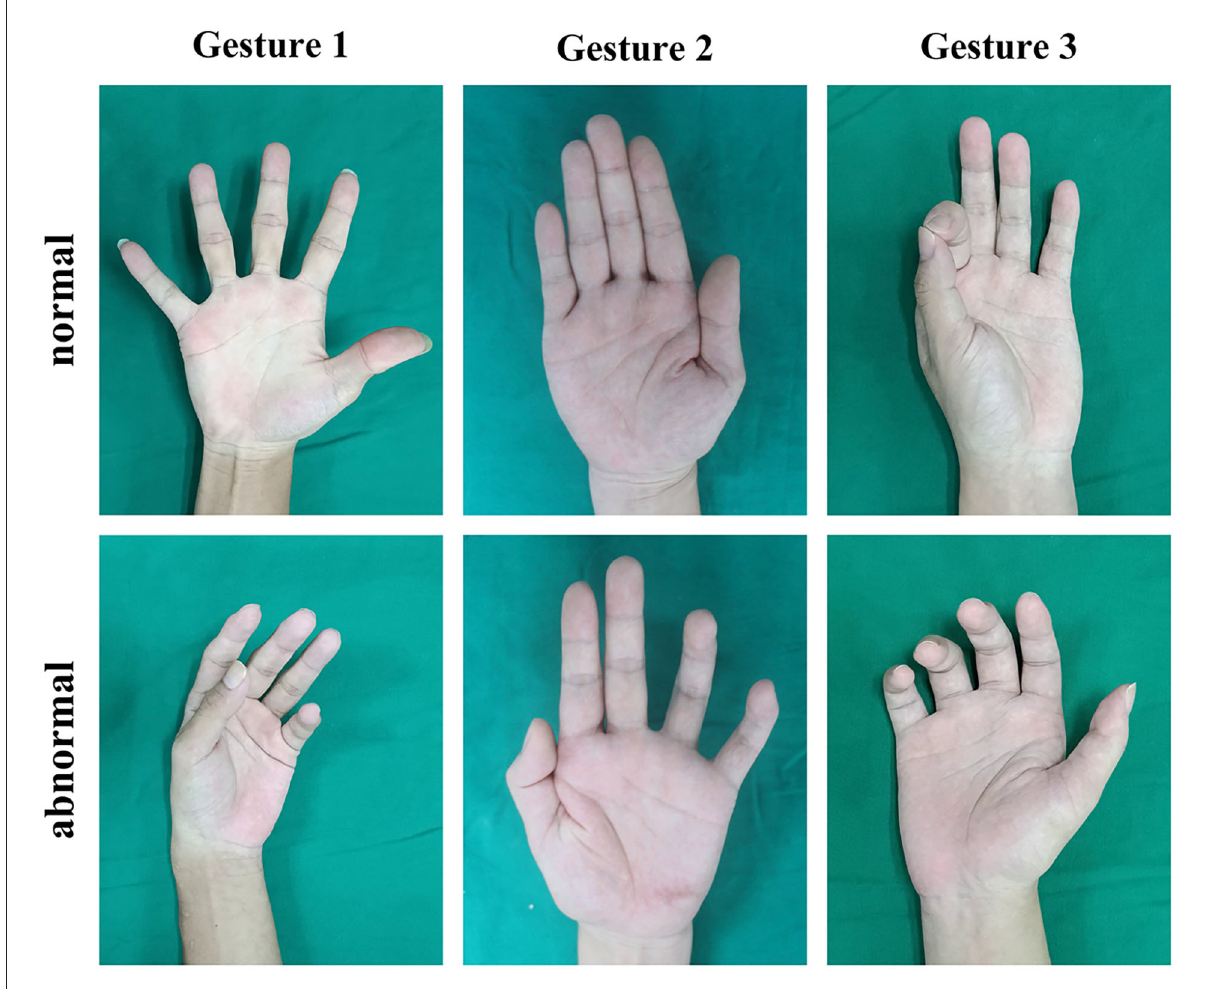
FIGURE2 Samples of normal and abnormal